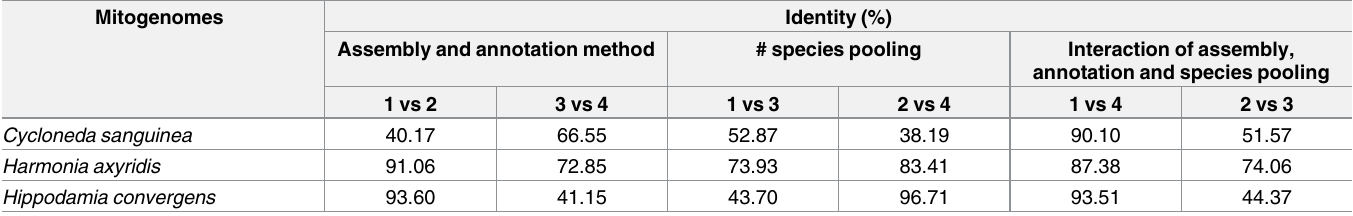
Table 3. Identity (%) among the mitogenomes generated by the different methods.